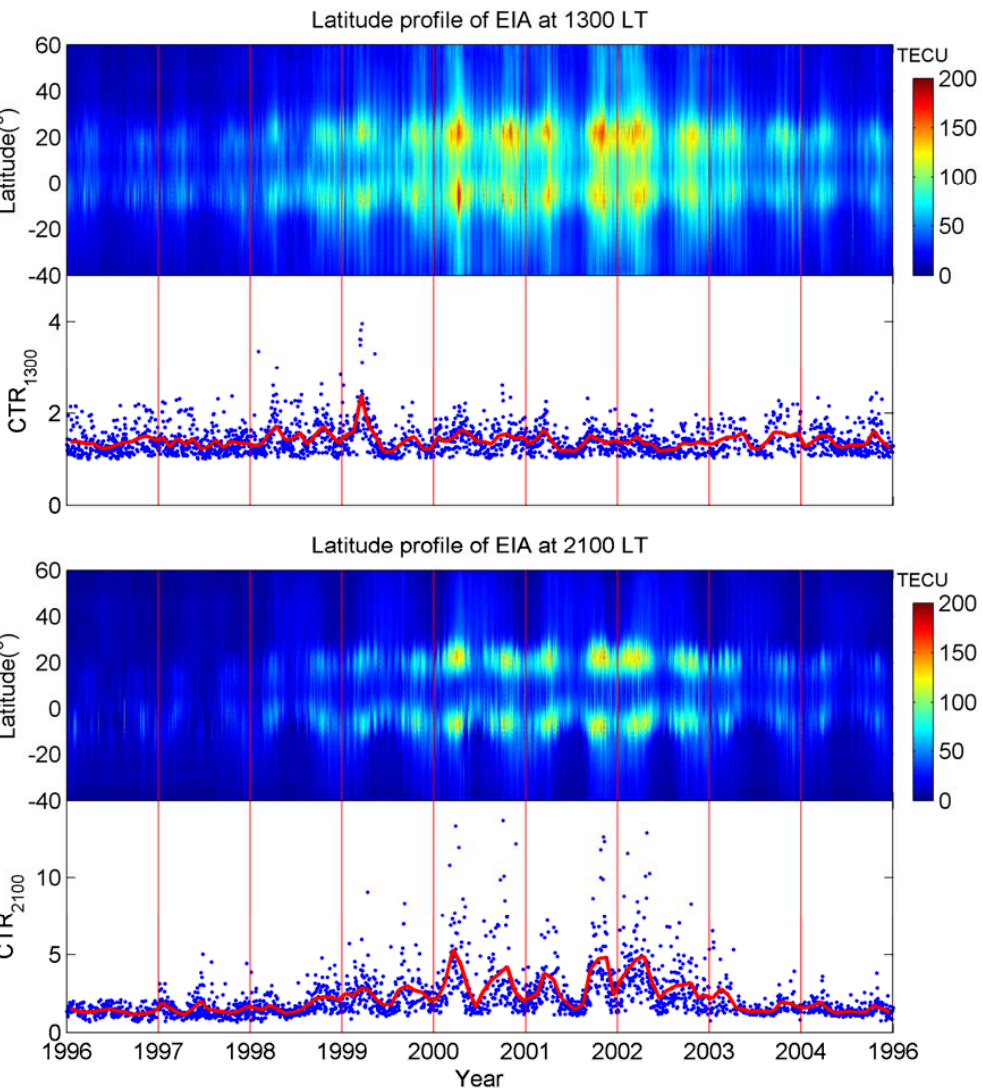
Fig. 8. Latitude profile of EIA and crest-to-trough ratio around 13:00 and 21:00LT during 1996–2004. The red lines denote the monthly Figure 8. Latitude profile of EIA and crest-to-trough ratio around 1300 and 2100 LT during mean 1996-2004. The red lines denote the monthly mean value.